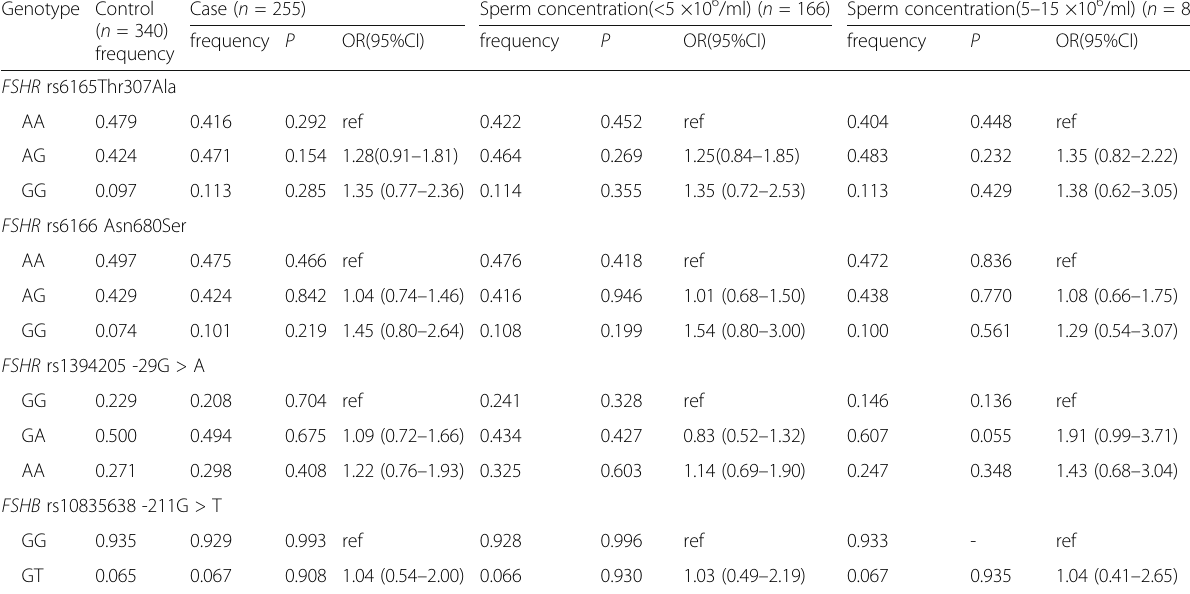
Table 2 Allele and genotype frequencies of the FSHR rs6165, rs6166 and rs1394205 genotypes and FSHB rs10835638 genotypes in the infertile and fertile groups Genotype Control ( n = 340)